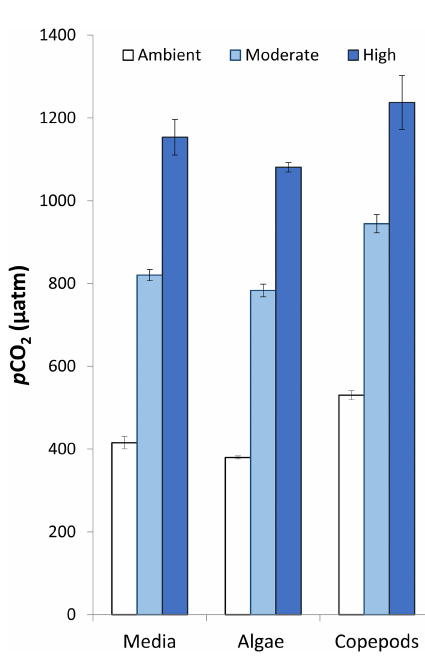
Figure 4. System performance as measured by maintenance of p CO 2 in pre-conditioned media, algal cultures (diatom Dytilum brightwellii ), and mixed cultures of the algae and the copepod Calanus pacificus ( n = 6, Experiment 2). Algae and copepods were under semi-continuous culture with artificial atmospheres and me- dia for daily dilutions was bubbled with air at 400 (ambient), 800 (moderate) and 1200 (high) µatm p CO 2 . Values are means; er- ror bars are standard